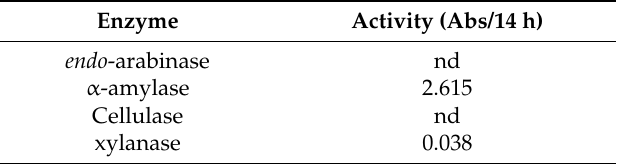
Table 5. Enzymatic activities on the native carbohydrate fraction (1% w / v ) after 14 h of